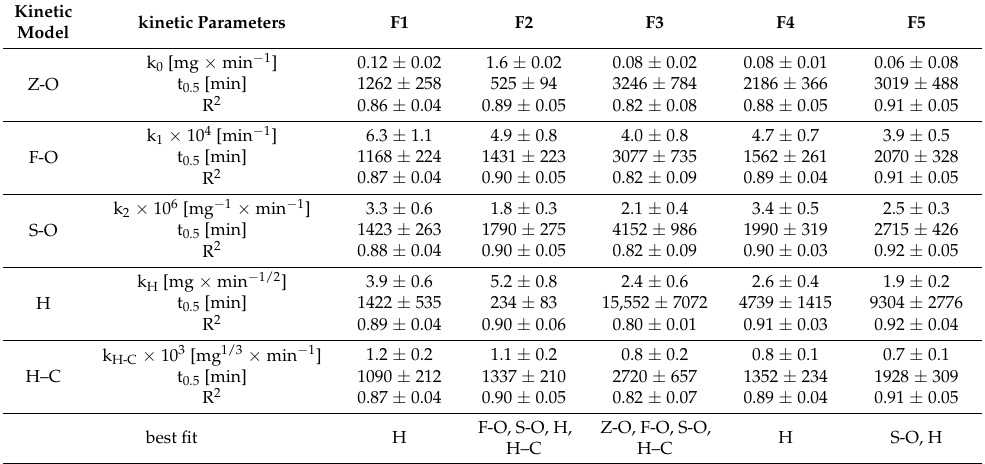
Table 3. The kinetic parameters of the second stage of the release of 5-ASA from F1–F5. Kinetic